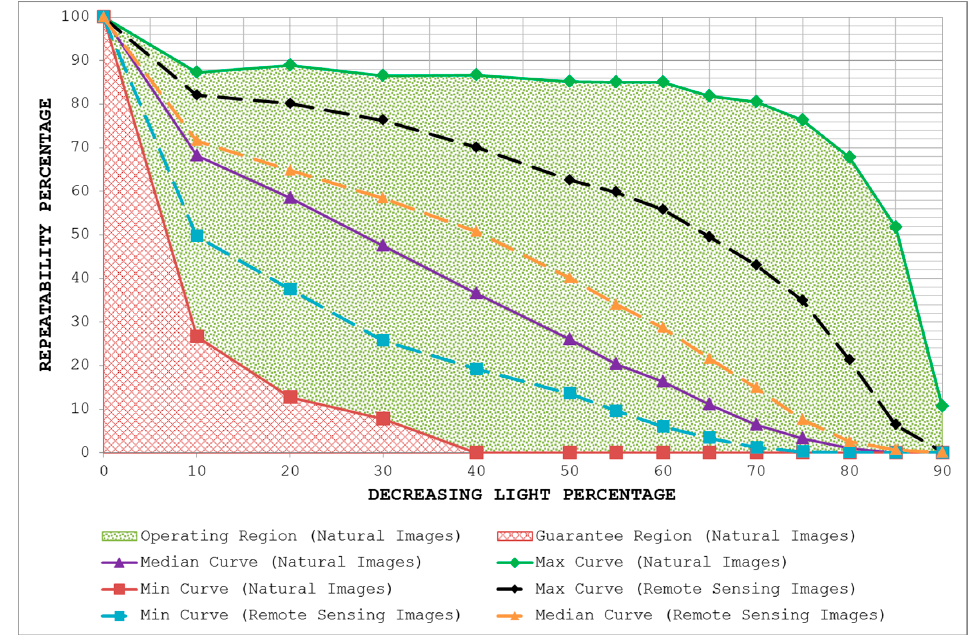
Figure 23. Results of EBR for remote sensing images under decreasing light. The two graphs (natural images and remote sensing images) are overlaid to produce one plot for EBR. Note that although the operating and guarantee regions are defined using the presented database of natural images [50], the curves (median, max and min) in the case of remote sensing images still lie inside the defined operating region and do not cross over to the guarantee region.